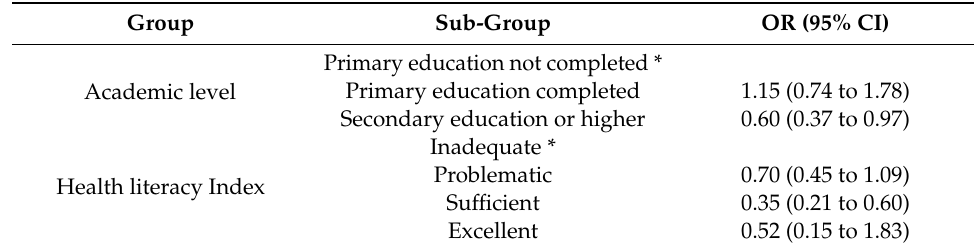
Table 5. Pairwise comparison of the means (Bonferroni